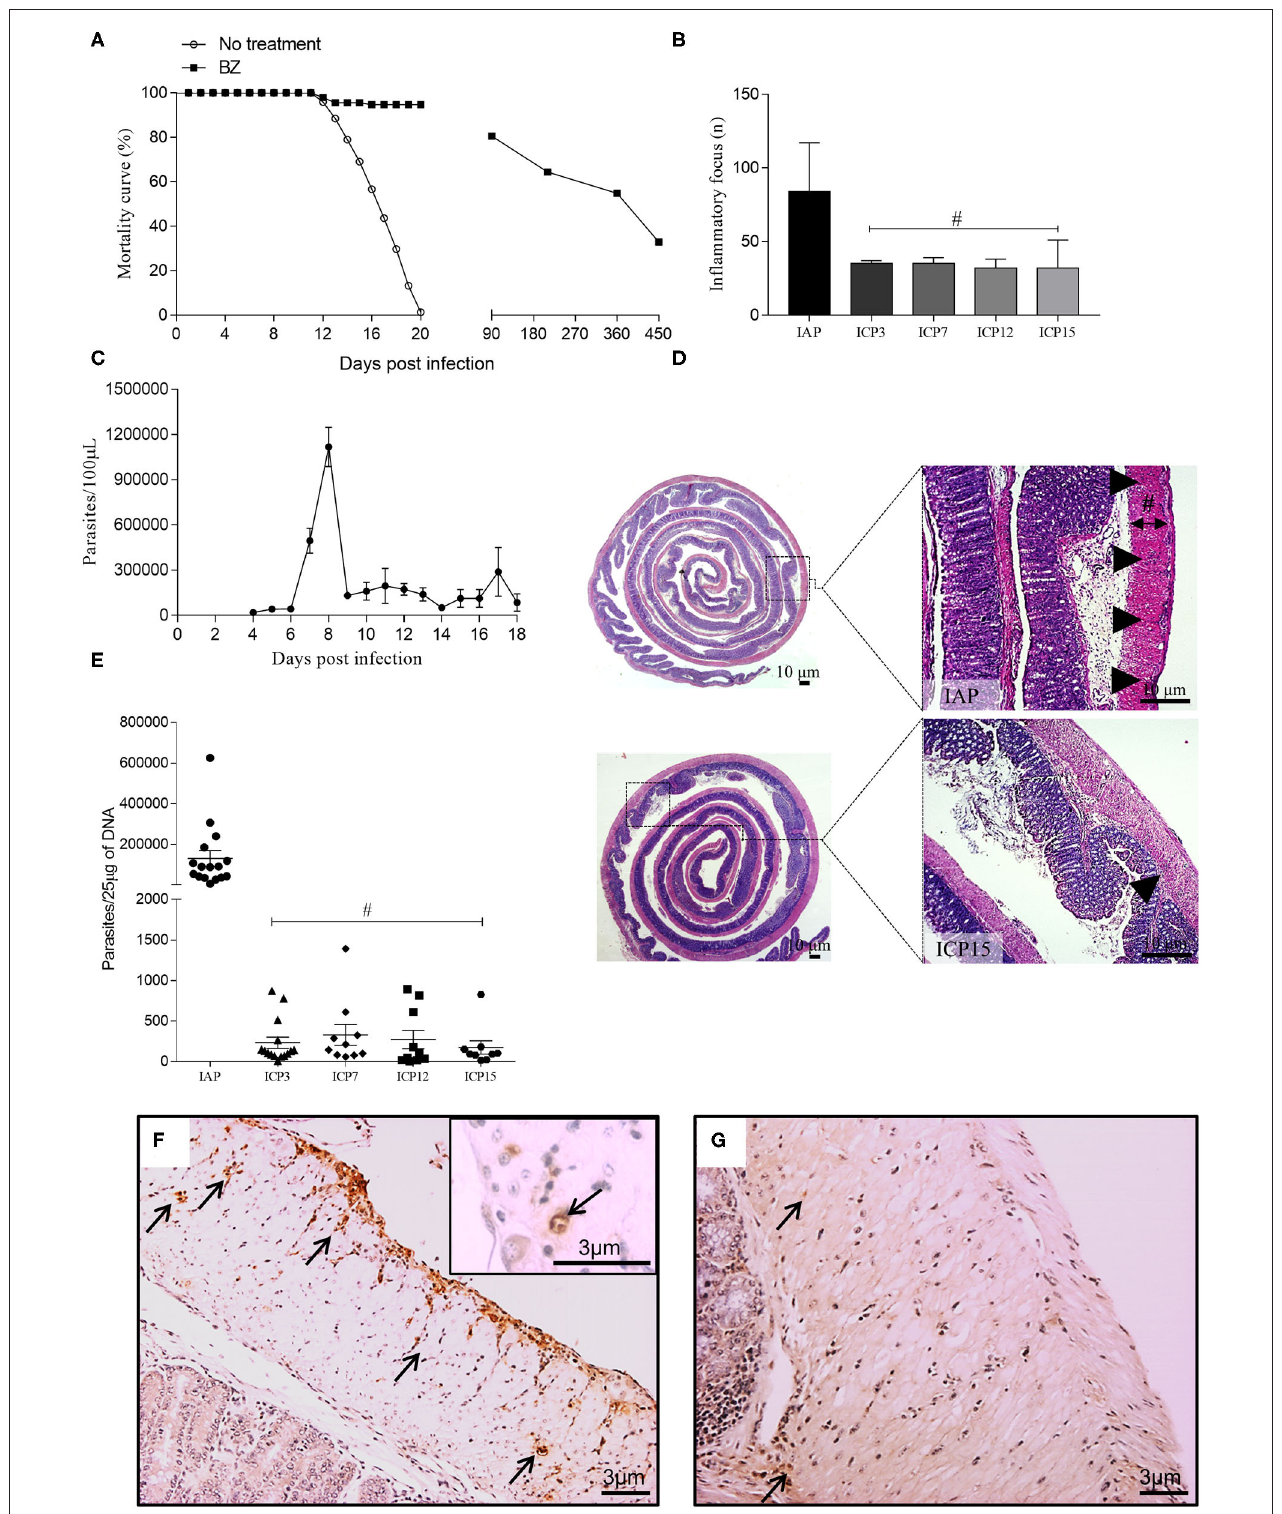
FIGURE 1 | Mortality curve, infection parameters, and characterization of the inflammation associated with parasitism throughout the infection. Swiss female mice were infected with 50,000 T. cruzi strain Y trypomastigotes. (A) Survival curve: The mice in the control group and those treated with benznidazole (BZ) were followed